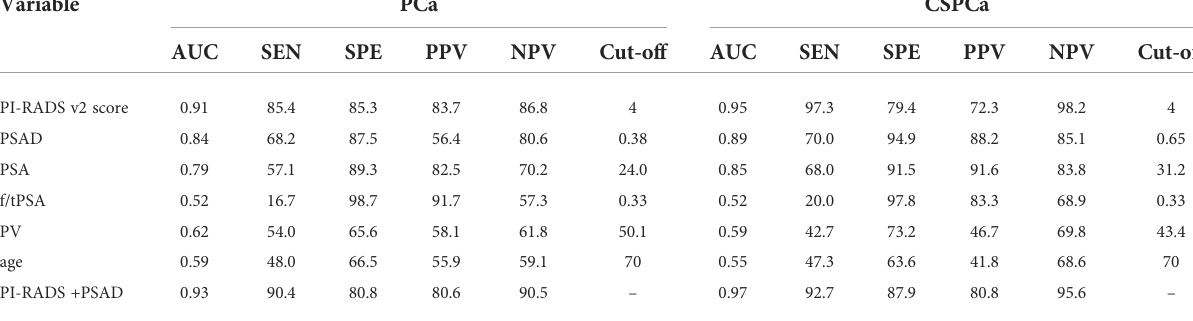
TABLE 3 Diagnostic performance of risk factors for PCa and CSPCa.